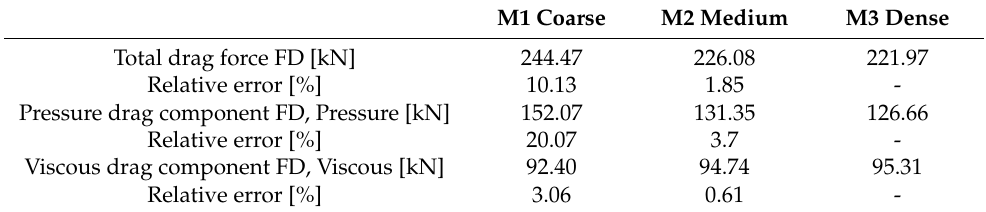
Table 4. Total drag force, pressure, and viscous components of the drag force for computational grids used in the grid sensitivity